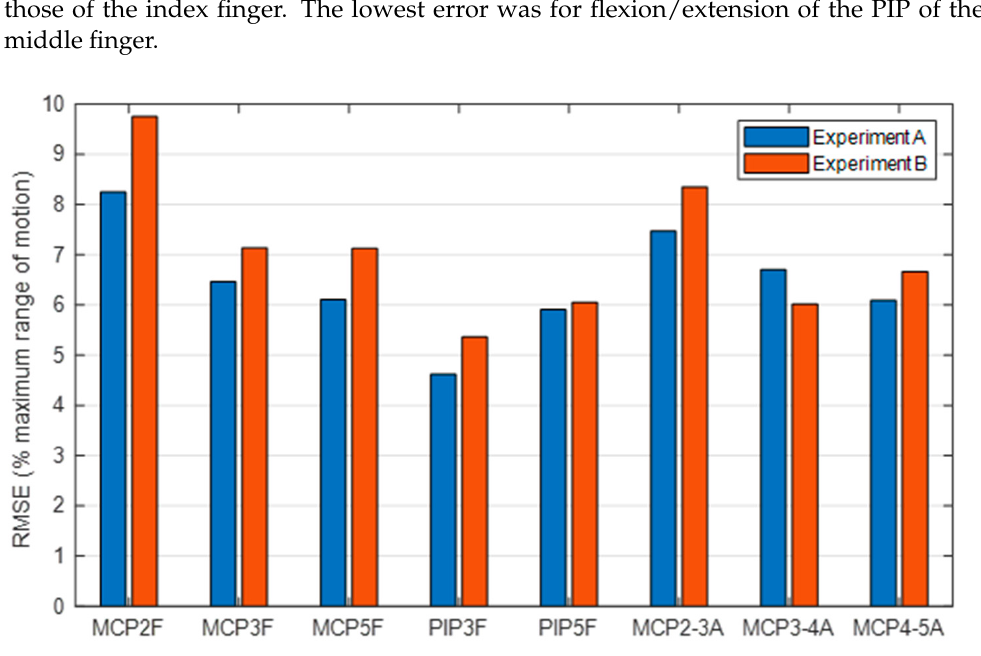
Figure 7. Global RMSE per joint (case #11) computed from all the frames and expressed as a percentage with respect to the RoM of each DoF for both experiments A and B. 1 to 5 refers to thumb to little fingers. F stands for flexion/extension and A for abduction/adduction movements.